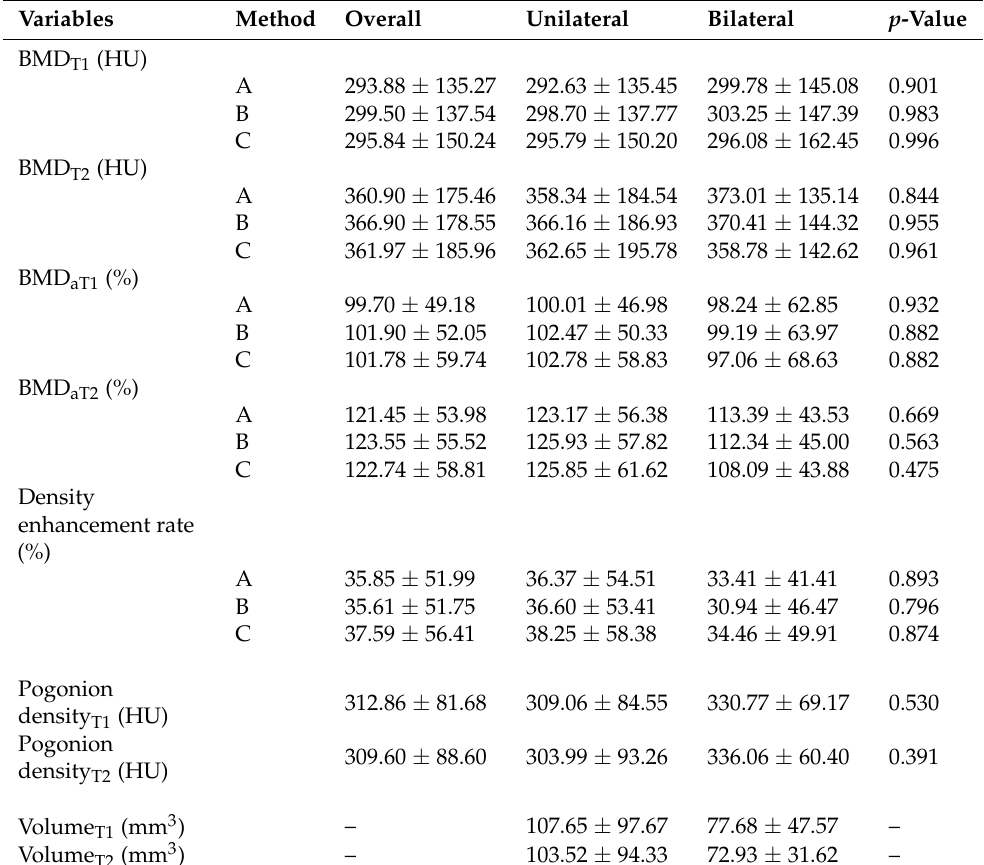
Table 2. Outcomes of cone beam computed